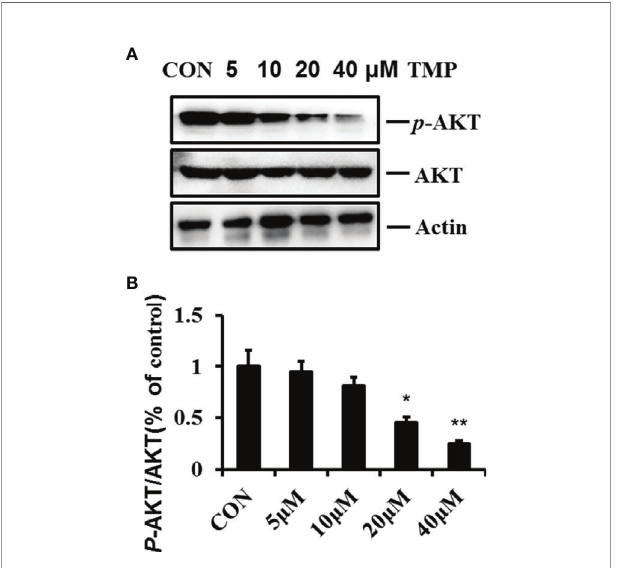
FIGURE 5 | TMP inhibits the phosphorylation of AKT in HFs. (A) Cell lysates were analyzed by immunoblotting and quanti fi ed. Representative immunoblots of AKT and p-AKT (Ser473) were shown, with Actin as the loading control. (B) Histogram summarized the results of (A) . Error bars represented means ± SD of n = 4. * p < 0.05 and ** p < 0.01 vs. control group. TMP, tetramethylpyrazine; HFs, HS-derived fi